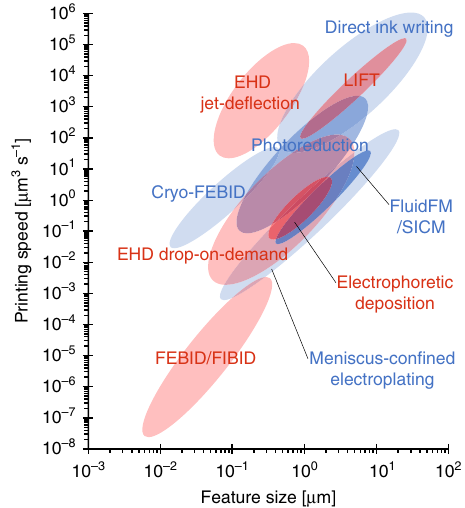
Fig. 7 Comparison of additive manufacturing technologies. Map of printing capabilities in terms of printing speed and feature size for manufacturing technologies providing submicron resolution. Adapted from Hirt et al. and extended to include EHD printing based on jet de fl ection 48